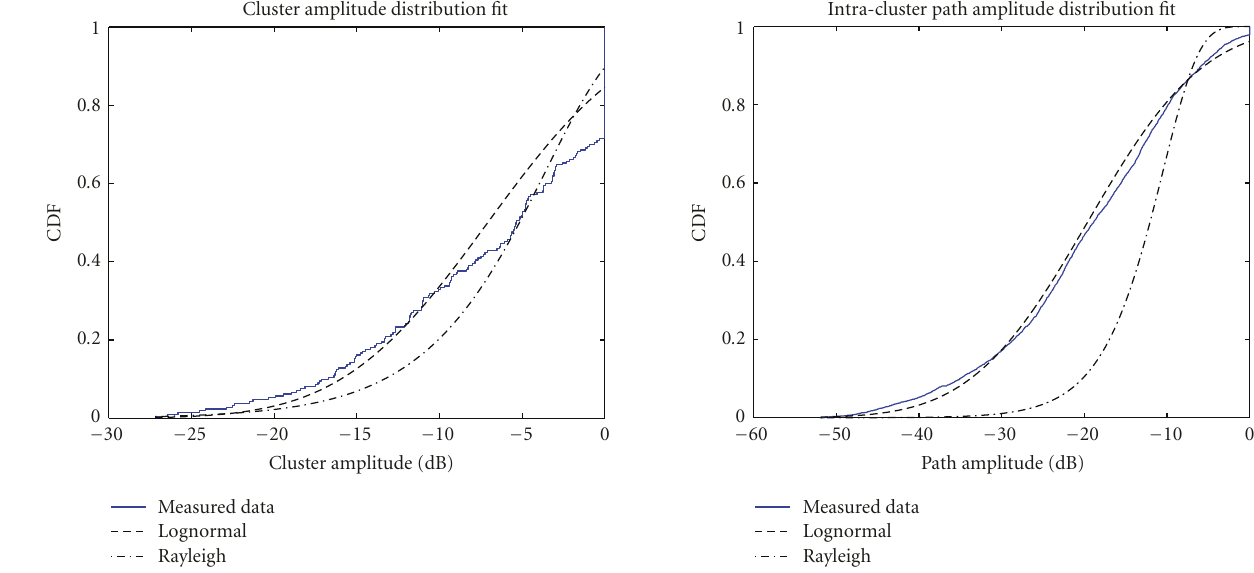
Figure 18: Intracluster path amplitudes CDF with the best-fit Rayleigh (RMSE = 0.2284) and lognormal (RMSE = 0.0319) distri- butions for measurements inside the Escalade engine compartment.